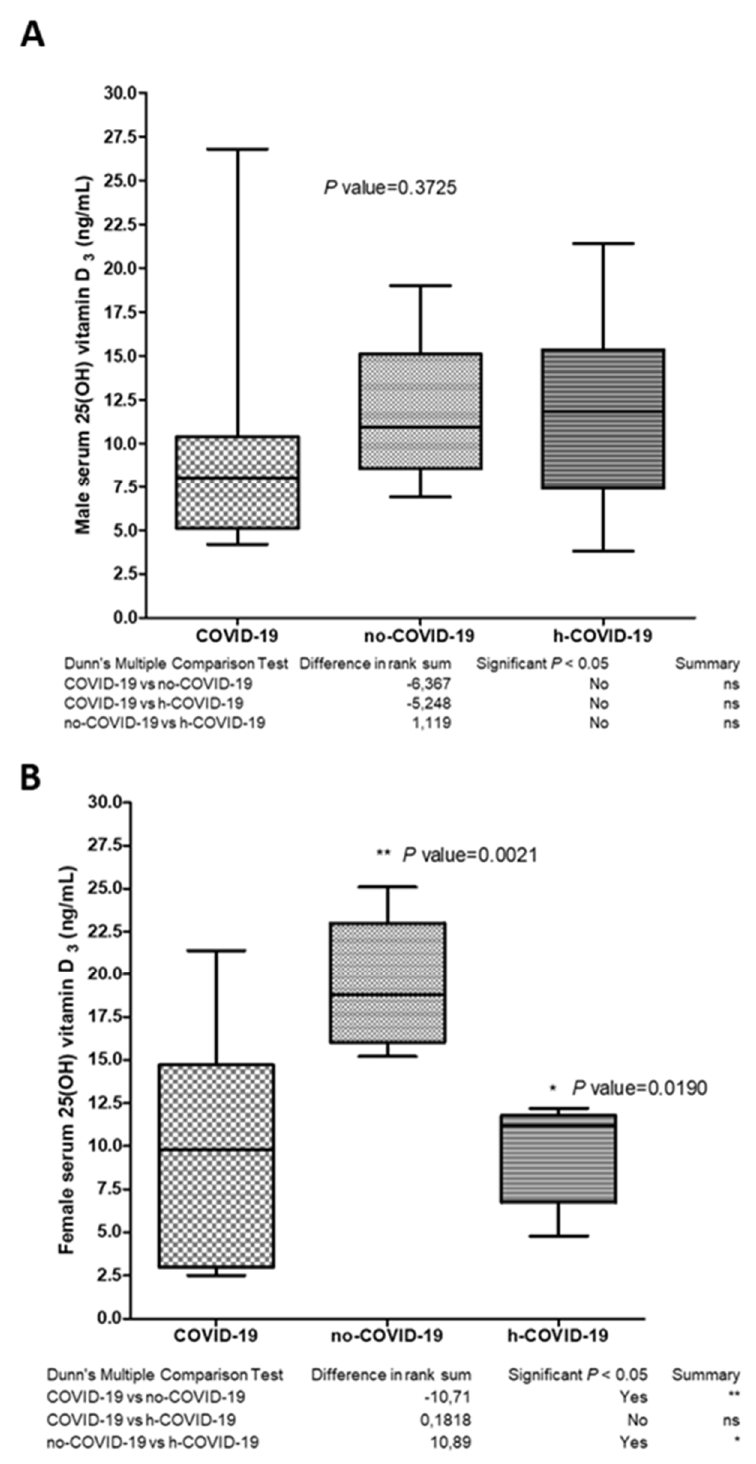
Figure 2. Serum 25(OH) vitamin D3 levels in COVID-19 (Group 1), no-COVID-19 (Group 2) and h-COVID (Group 3), dived per sex in A) male and B) female. ns = not significant. * p value=0.0190, ** p value = 0.0021, ** p value = Overall, six patients belonging to Group 2 (COVID-19, four females and two males) showed extremely low serum 25(OH)D 3 levels (<1 ng/mL). As per our secondary endpoint, we assessed circulating IL-6 levels in this subgroup of patients with extreme hypovitaminosis D (see Table 1 for further details).